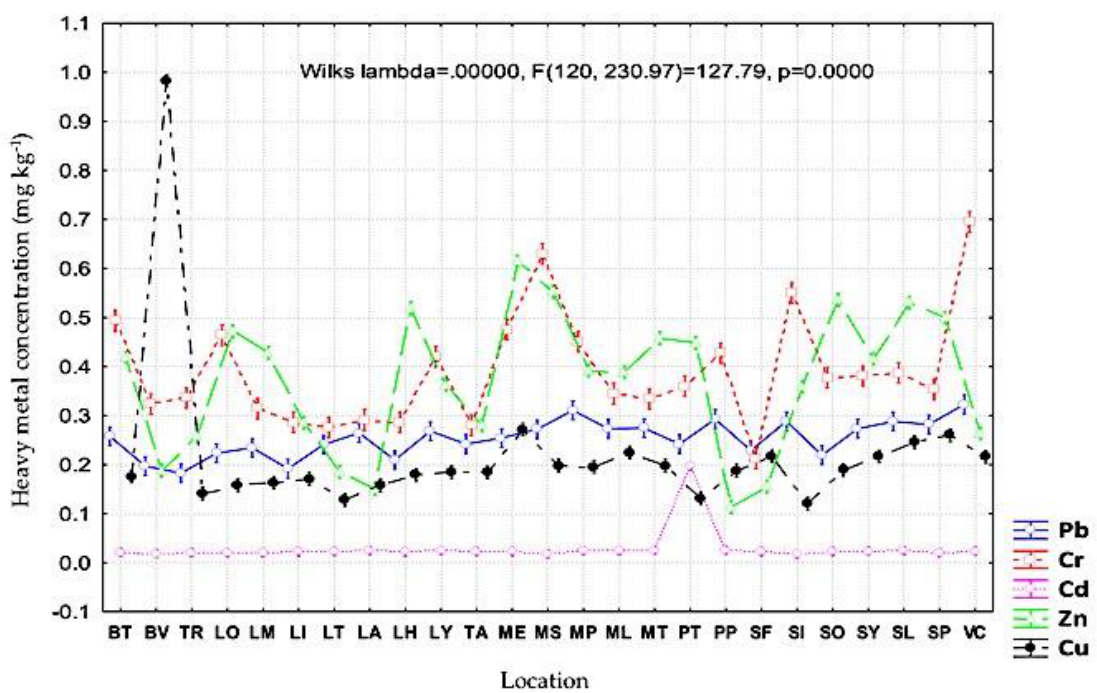
Figure 3. Heavy metal concentration in soil of the sampling sites of the study area of the Sotavento region in the central area of the Gulf of Mexico.